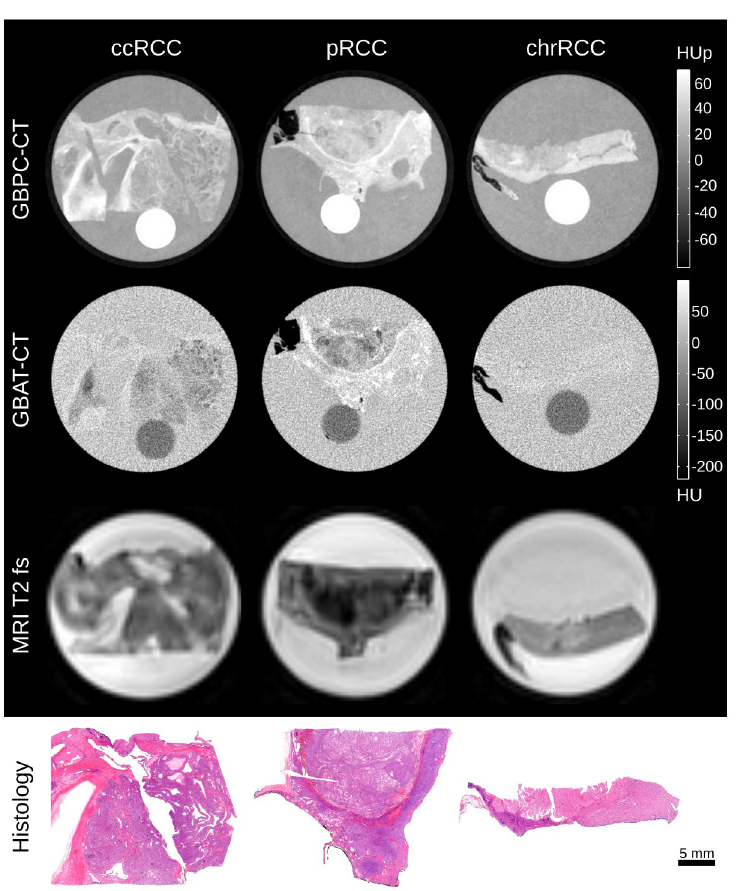
Fig 3. Preclinical imaging results of renal cell carcinomas in histopathological correlation. Representative slices of a ccRCC, pRCC and chrRCC obtained with GBPC-CT, GBAC-CT and T2 fat saturated MRI (MRI T2 fs). The bottom row shows the corresponding histological slices that were obtained for validation with HE-staining. HU: Hounsfield units, HUp: Hounsfield units phase, mfAML: minimal-fat angiomyolipoma, hfAML: high-fat angiomyolipoma, ccRCC: clear cell renal cell carcinoma pRCC: papillary renal cell carcinoma, chrRCC: chromophobe renal cell carcinoma, GBPC-CT: grating-based phase-contrast computed tomography, GBAC-CT: grating-based attenuation- contrast computed tomography, MRI T2 fs: magnetic resonance imaging with T2 fat